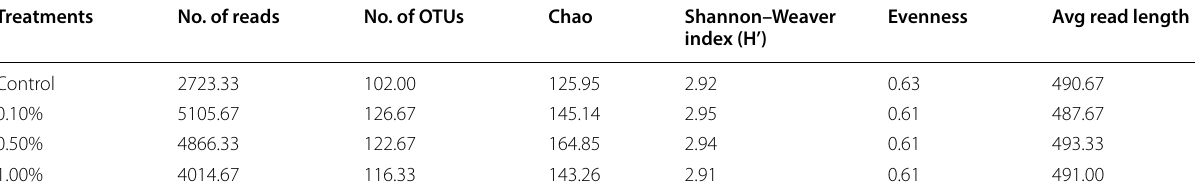
Table 6 Summary of the pyrosequencing data and statistical analysis of archaeal communities of Enterococcus faecium SROD